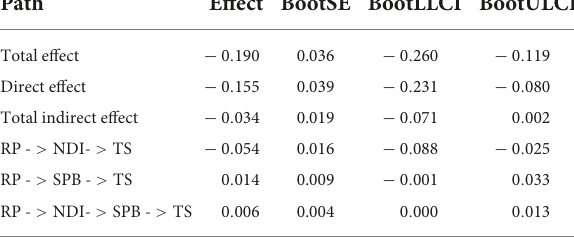
TABLE 6 Results of mediation